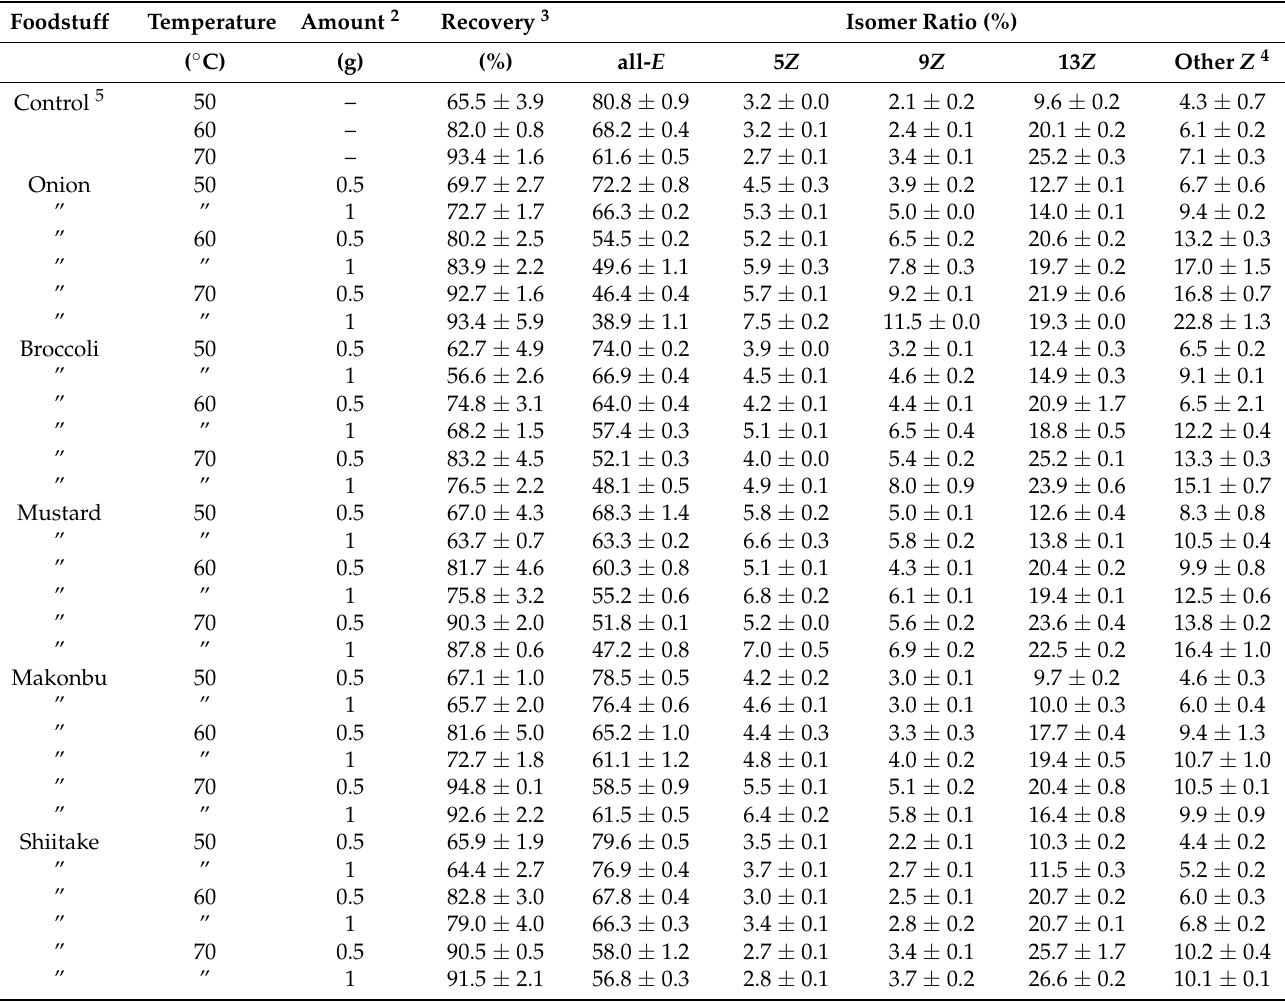
Table 1. Effects of extraction temperature and foodstuffs on lycopene recovery and each lycopene isomer ratio in the extract. 1.